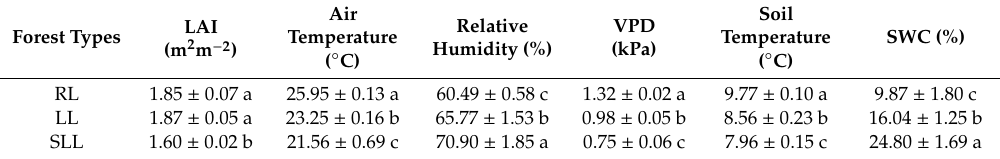
Table 12. Mean values of environmental factors of the three types of larch forest.